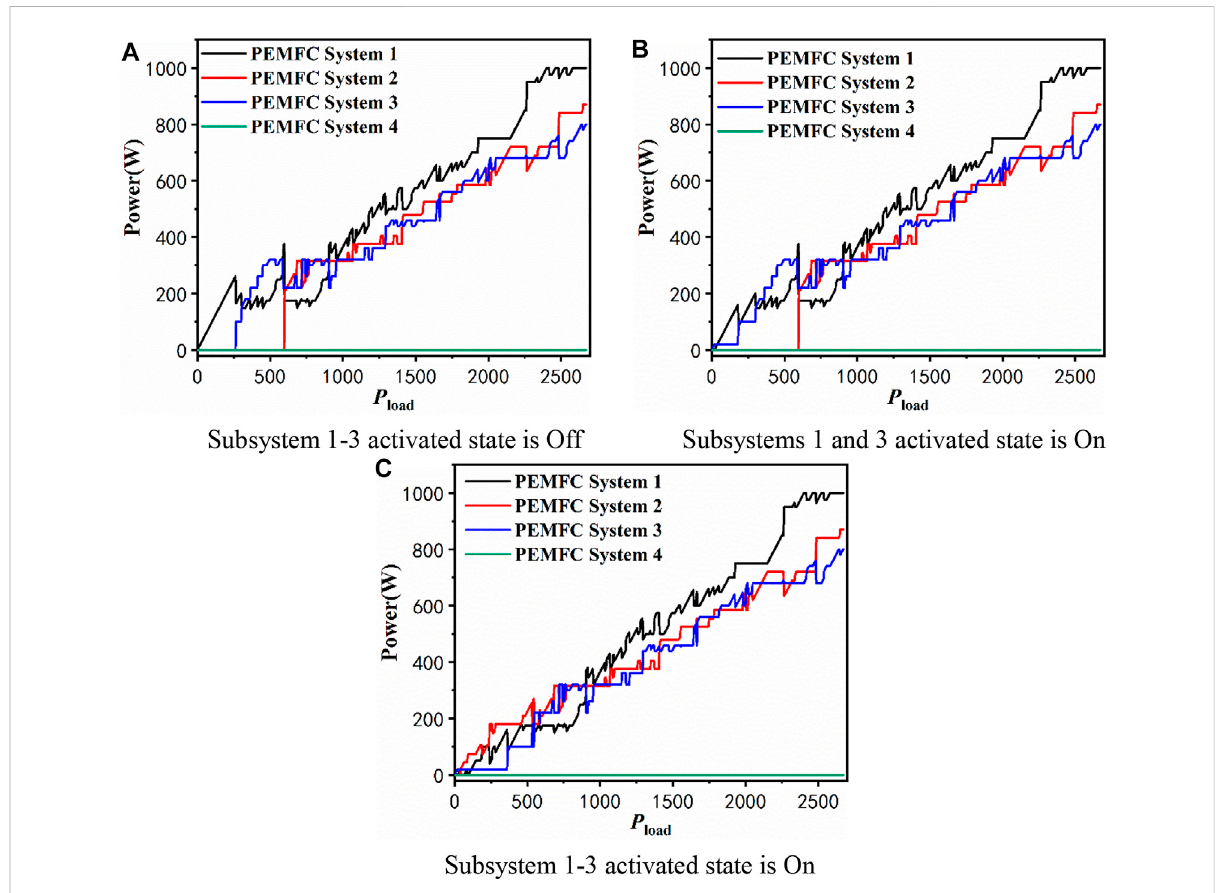
FIGURE 5 Power allocation strategy with FC4 fault. (A) Activated state of subsystems 1 – 3 is Off. (B) Activated state of subsystems 1 and 3 is On. (C) Activated state of subsystems 1 – 3 is